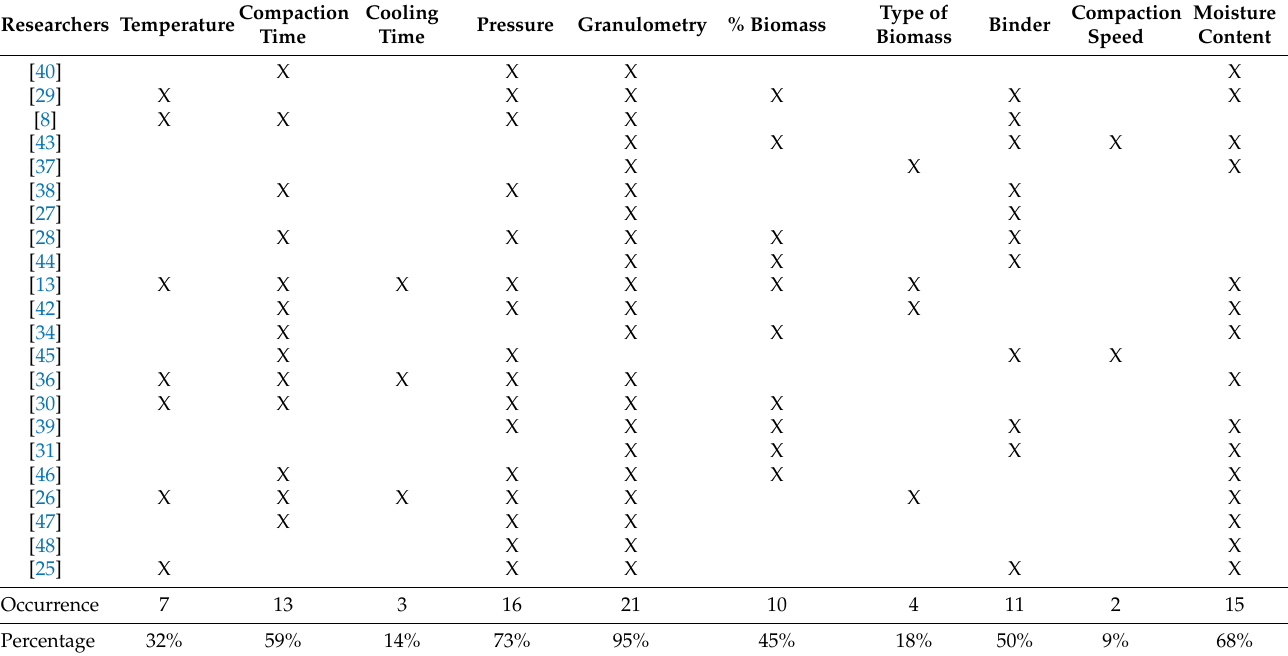
Table 2. Main input variables for briquette